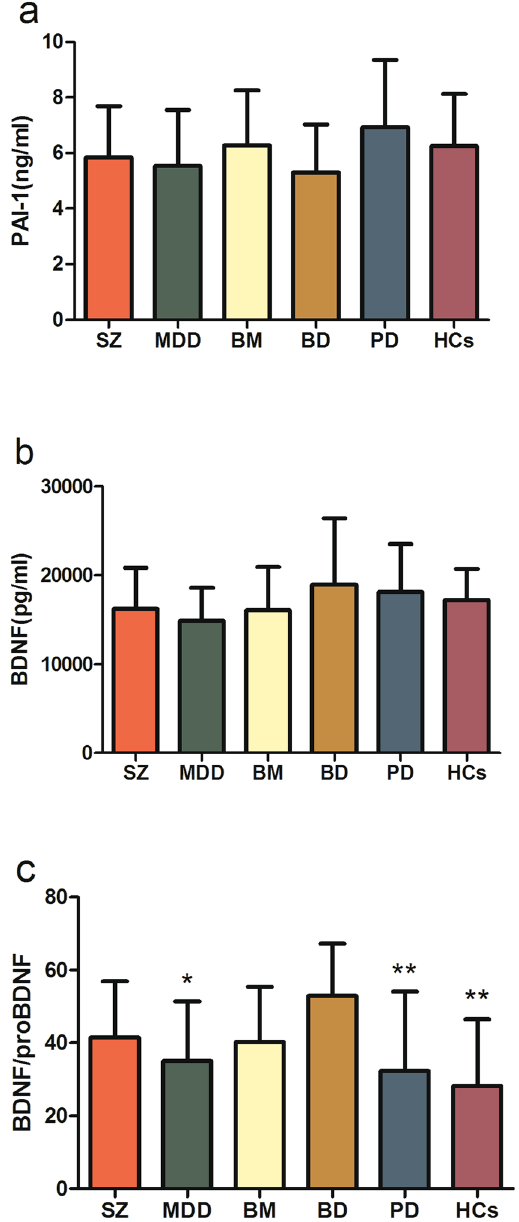
Figure 2. Serum concentrations of PAI-1 and BDNF and BDNF/proBDNF ratio in patients with different disorders and HCs. ( a ) PAI-1serum concentrations in patients with different disorders and HCs. ( b ) BDNF serum concentrations in patients with different disorders and HCs. ( c ) The value of BDNF/proBDNF in patients with different disorders and HCs. Abbreviations: SZ, schizophrenia; MDD, major depressive disorder; BM, bipolar mania; BD, bipolar depression; PD, panic disorder; HCs, healthy controls; PAI-1, plasminogen activator inhibitor-1; BDNF, brain-derived neurotrophic factor. Compared with BD group by Kruskal-Wallis test followed by Bonferroni test, * P < 0.05, ** P < 0.01. Several extreme values which higher than three standard deviations were removed out from PAI-1 and the value of BDNF/proBDNF. After removing out the extreme values, the remaining number of cases showed as follows: PAI-1 (34 SZ, 30 MDD, 30 BM, 22 BD, 29 PD and 30 HCs) and BDNF/proBDNF (32 SZ, 28 MDD, 29 BM, 21 BD, 28 PD and 28